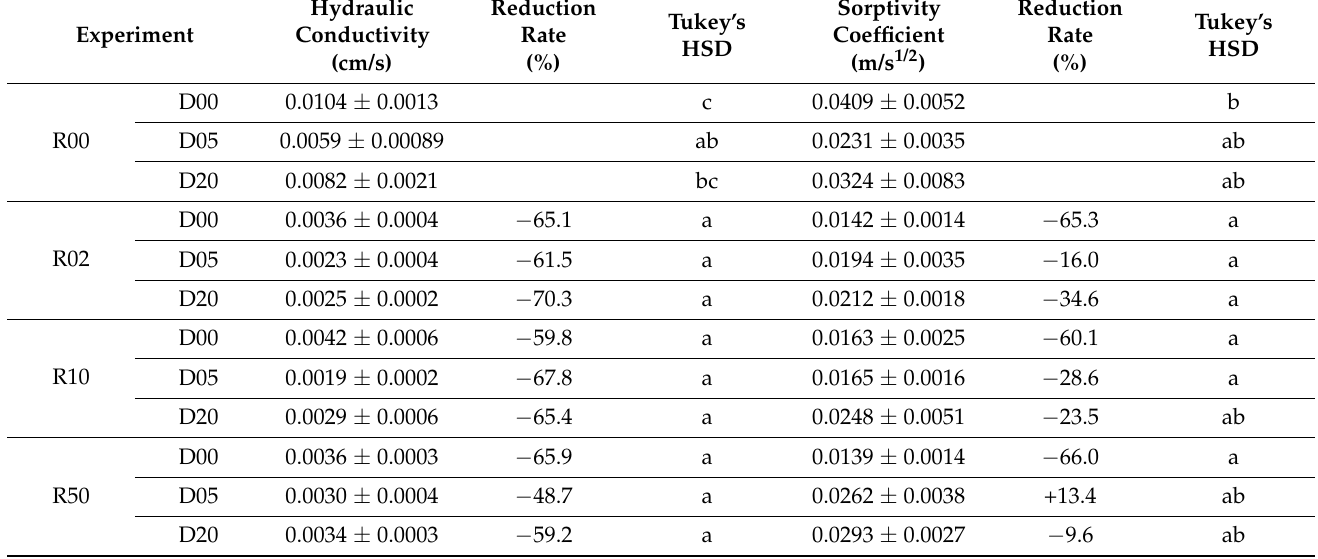
Table 4. Hydraulic conductivity and sorptivity of ash-covered